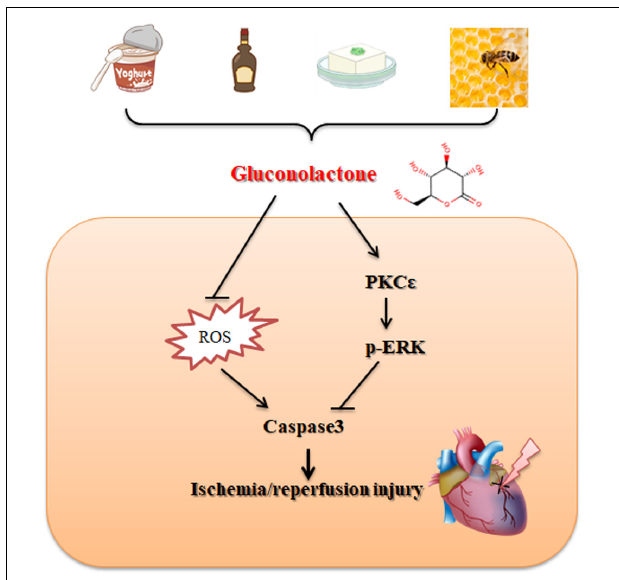
FIGURE 8 | Schematic illustrating the cardioprotective effect of GDL against I/R injury.